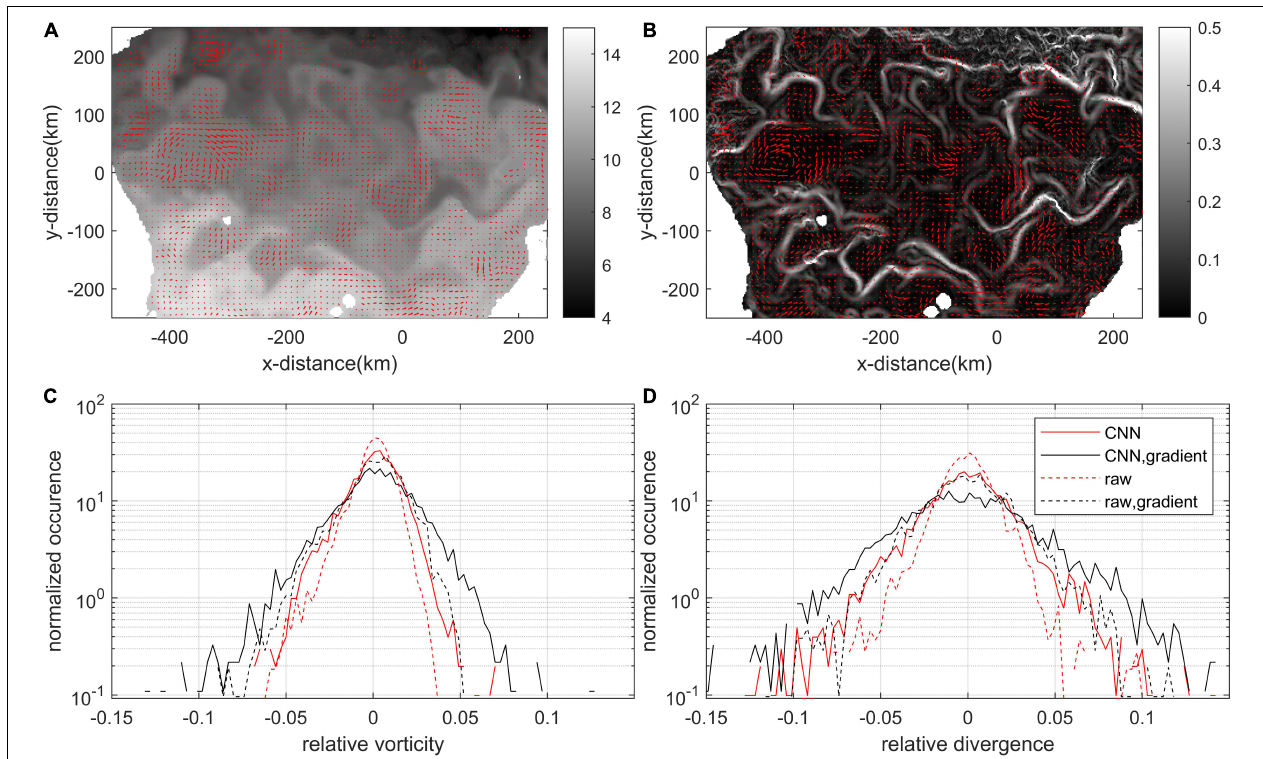
FIGURE 4 | One-day averaged surface current in a 10 km-grid in the East/Japan Sea on 25th March 2018 derived from Himawari SST (A) and Himawari SST gradient (B) and corresponding scalar fields. 22 hourly velocity fields derived from 23 consecutive SST images were used to calculate the mean surface current for that date. The scattered cloud area accounted for about 68%, and the area excluding the cloud area was used to calculate the mean velocity field. (C,D) Indicate vorticity and divergence PDF normalized by local Coriolis parameter. In the legend, “CNN” indicates 1-day averaged surface current using vectors filtered by CNN, “raw” indicates 1-day averaged surface current without CNN filtering, and “gradient” indicates surface current derived from SST gradient. The standard derivation (STD) of the PDF are 0.0158 (CNN), 0.0254 (CNN-gradient), 0.0117 (raw), and 0.0183 (raw-gradient) for relative vorticity, and 0.0288 (CNN), 0.0420 (CNN-gradient), 0.0181 (raw), and 0.0284 (raw-gradient) for relative divergence. The changes in STD show that flatter PDF (or smaller circulations) can be obtained by CNN-filtering and taking gradient of a scalar